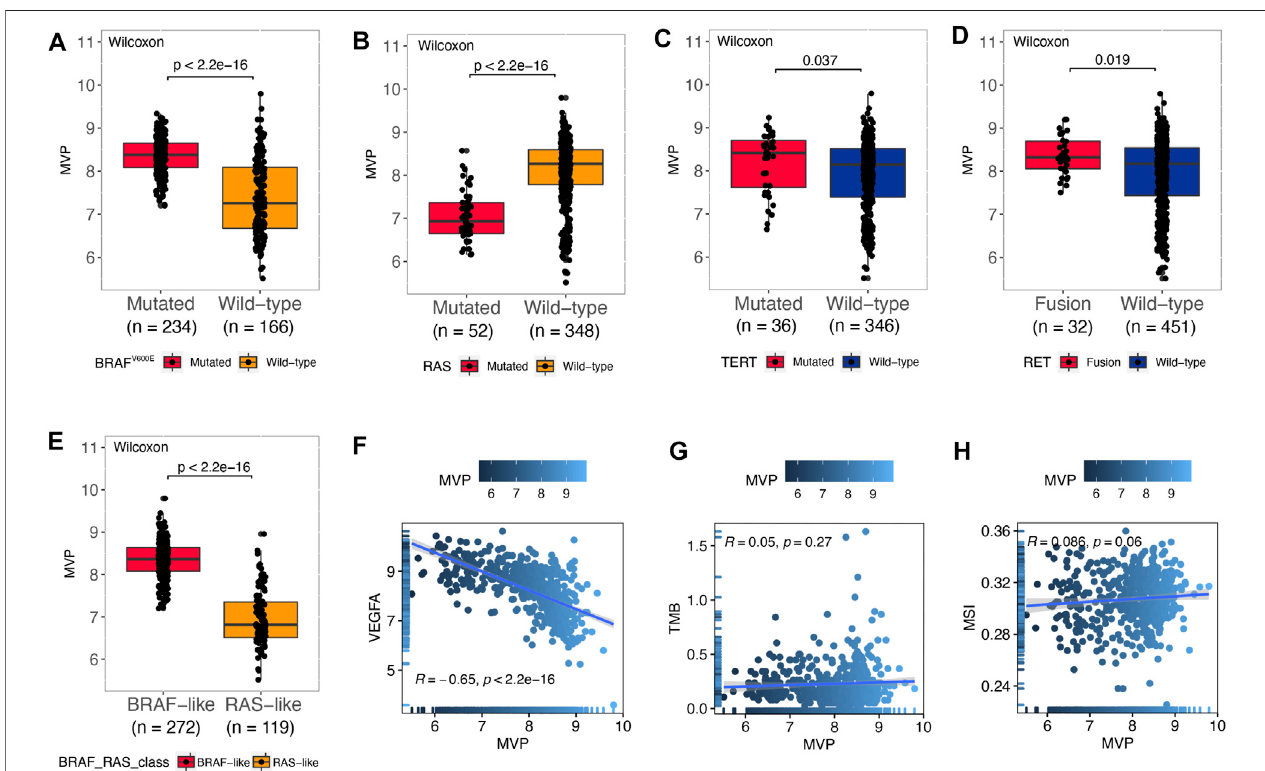
FIGURE 3 | MVP was correlated with molecular characteristics in PTC. (A – E) MVP expression in PTC patients with different genotypic features: (A) BRAF V600E pattern, (B) RAS pattern, (C) TERT pattern, (D) RET pattern, and (E) BVL/RL. (F – H) Spearman ’ s correlations between MVP expression and (F) VEGFA , (G) TMB, and (H)